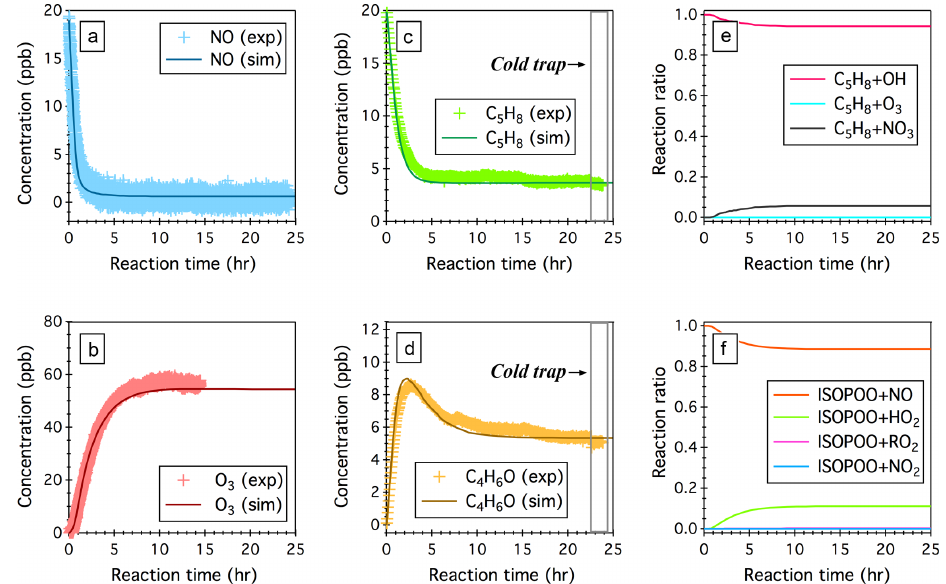
Figure 3. Simulated (sim.) and observed (exp.) temporal profiles of (a) NO, (b) O 3 , (c) isoprene (C 5 H 8 ), and (d) the sum of MACR and MVK (C 4 H 6 O) over 24h OH-initiated oxidation of isoprene in the continuous flow mode chamber operation. Also displayed here include (e) simulated fractions of OH oxidation, ozonolysis, and NO 3 oxidation as the removal pathways of isoprene and (f) simulated fractions of ISOPOO radicals that react with NO, HO 2 , RO 2 , and NO 3 . Time 0 is the point at which the chamber lights are turned on. Initial experimental conditions are 19ppb NO, 0ppb NO 2 , 0ppb O 3 , 600ppb H 2 O 2 , and 19.9ppb C 5 H 8 , with continuous input of 600ppb H 2 O 2 , 19ppb NO, and 19.9ppb C 5 H 8 over the course of 24h photochemical reactions.